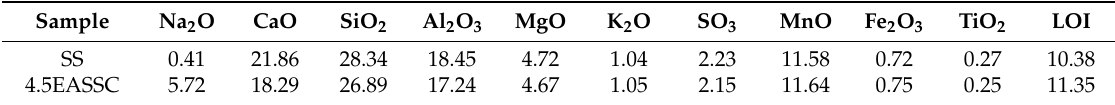
Table 1. Oxide composition of samples (wt